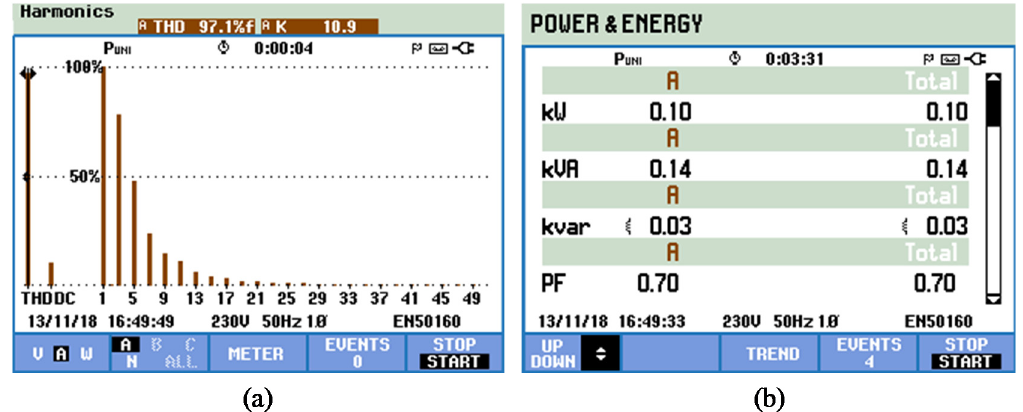
Figure 14. Experimental results without the operation of the MF-EVCS (in V2G mode): ( a ) Harmonic